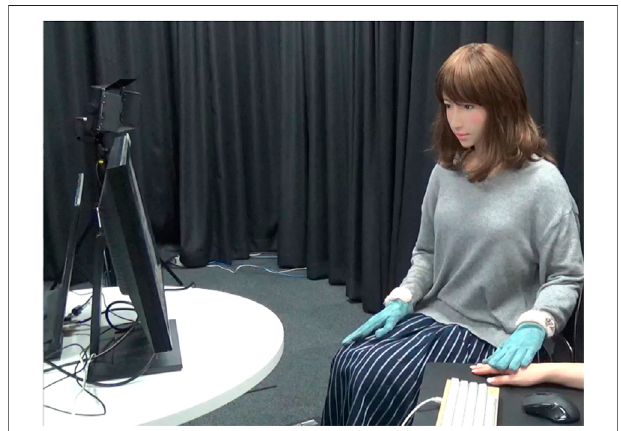
FIGURE 1 | Participant and ERICA watch a